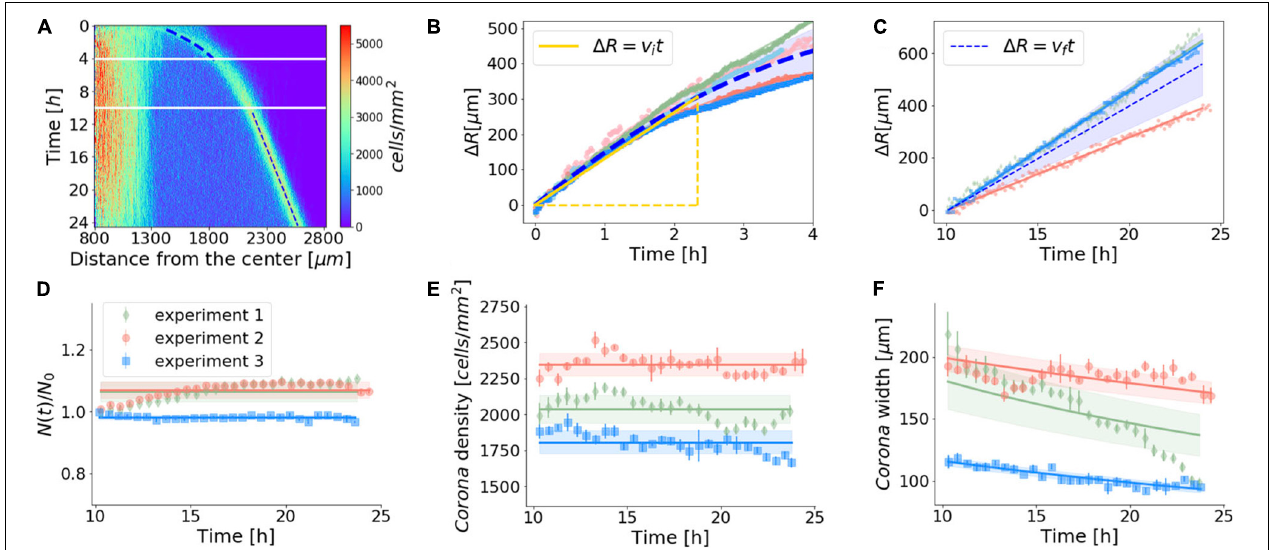
FIGURE 3 | Quantitative description of the aerotactic pattern of growing Dictyostelium wild-type cells. (A) Cell density for the confined system over 24 h as a function of radial distance and time; blue dashed lines highlight the dynamics of the front in the two time windows that were then studied in detail. Heatmap revealed that over a 24-h time period the very inner core of the cell cluster and the area between the latter and the corona maintained two distinct but unaltered density profiles. (B,C) Time evolution of corona displacement: blue dashed lines represent the average trends [ (cid:49) R(t)], computed via the mean value of the corona displacement measured in different experiments (corresponding to different colors); at any time, the variability of (cid:49) R among the experiments was quantified by the standard deviation, represented by the blue shaded regions. (B) Early hours after corona formation: the yellow line shows the time range used to define the initial speed of the front, < v i > = 2.2 ± 0.2 µ m/min (mean value ± standard deviation, measured over five independent experiments). (C) Ten hours after confinement, the displacement of the ring grew linearly with time, i.e., with constant velocity v f . This value displayed large statistical variability among three different experiments, < v f > = 0.67 ± 0.14 µ m/min. In panels (D–F) , the continuous lines and the shaded regions correspond to the model of a circular ring of cells that enlarges in radius while keeping the cell density constant without any cell duplication. (D) Number of cells over time (estimated as described in Supplementary Figure 3 ) indicated that cell duplication played a minor role when the ring propagated at constant velocity. Ratio between the number of cells N(t) and the one measured 10 h after the confinement of the colony [N 0 = N ( t = 10 h)] was approximately constant. (E) Cell density of the corona remained constant as the corona moves radially. Its value was comparable to the cell density detected in the inner region of the center of the colony. (F) Width of the front decreases as it escapes